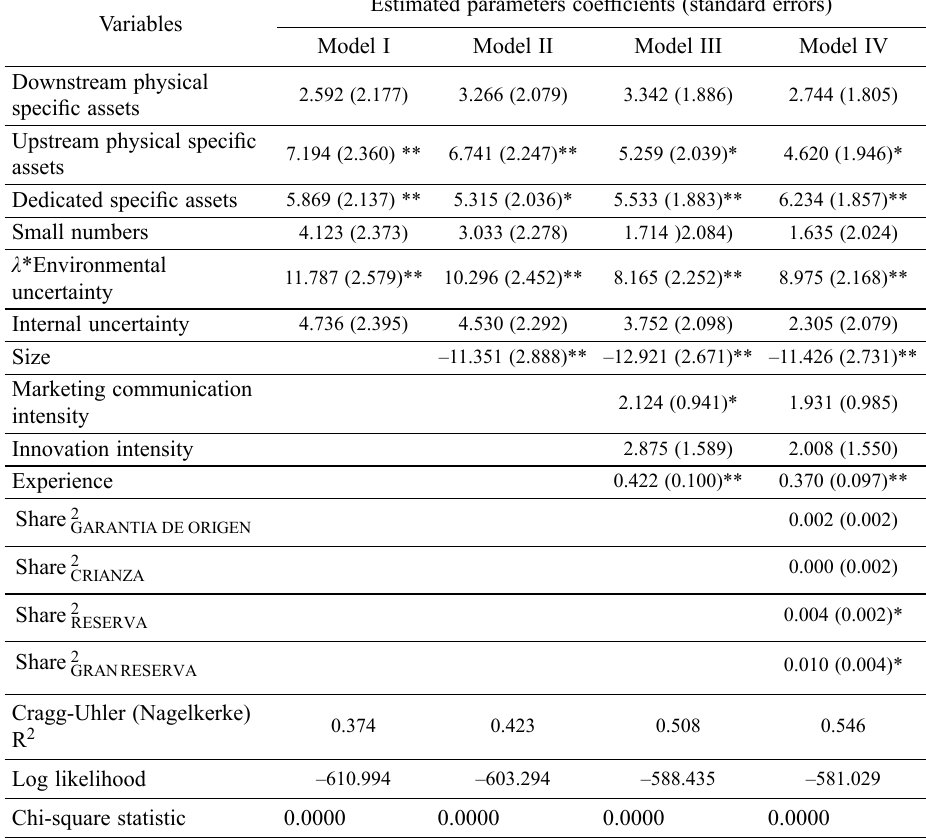
Table 1. Estimates using Tobit for censored data at two extremes (0,